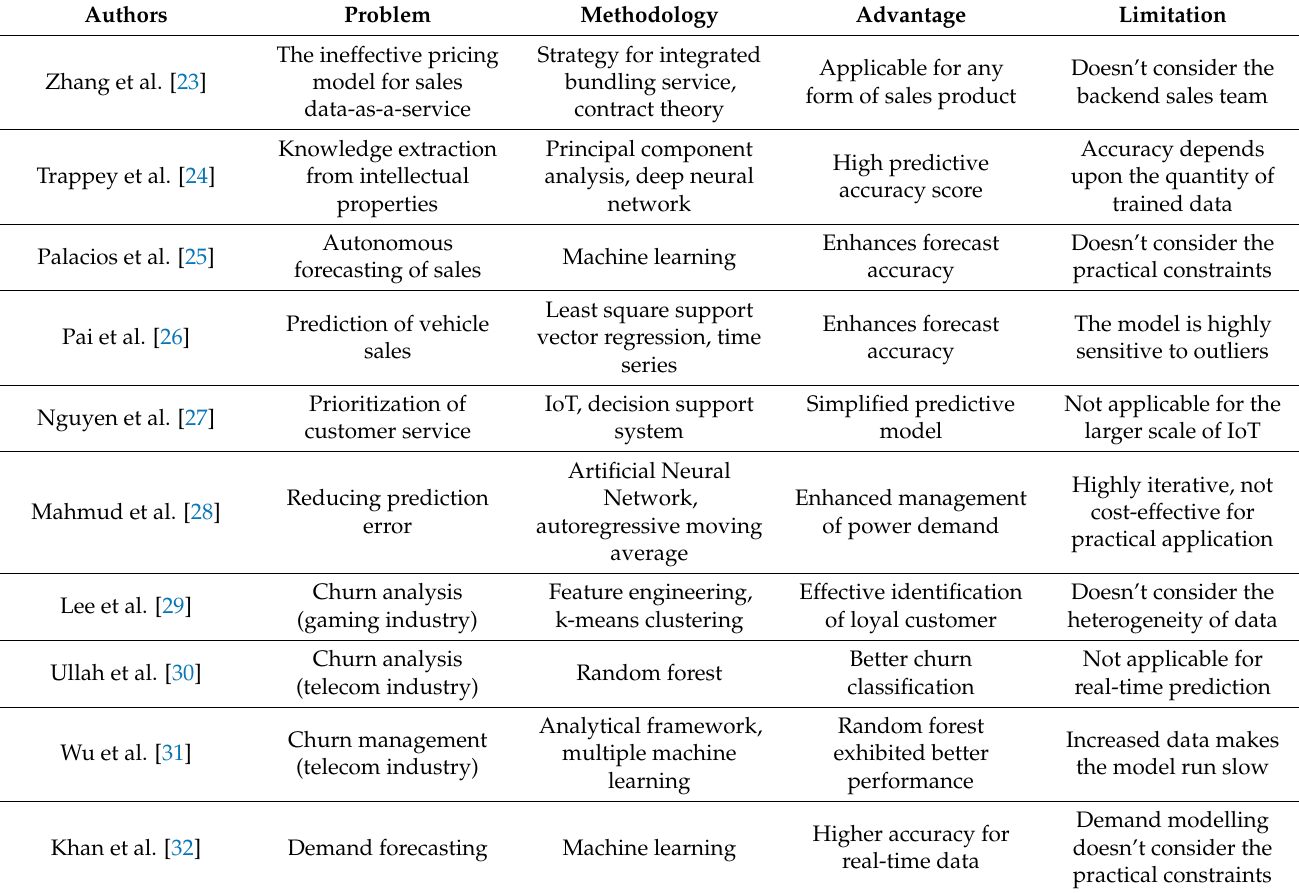
Table 1. Summary of analysis of existing